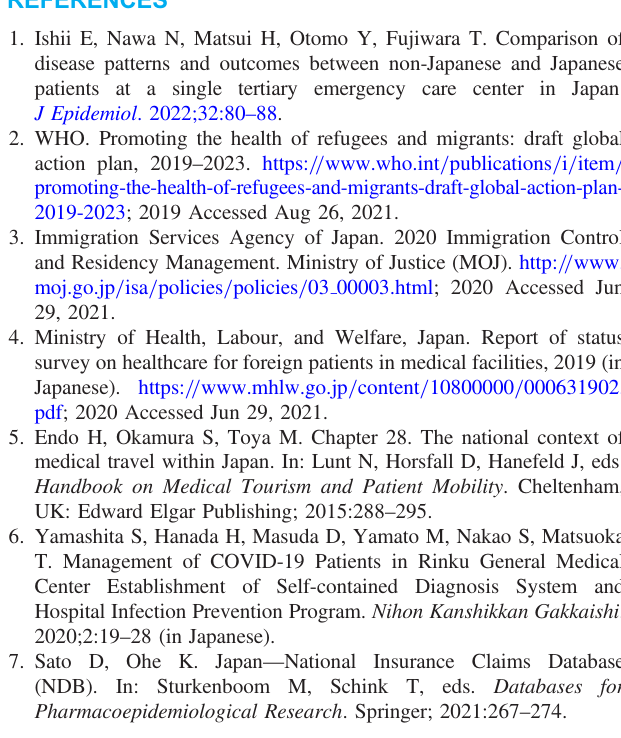
Table 2. Classi fi cation of foreign patients into visitors or residents